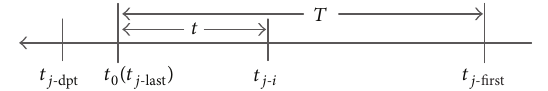
Figure 2: The time analysis on passengers’ arrival of waiting room.